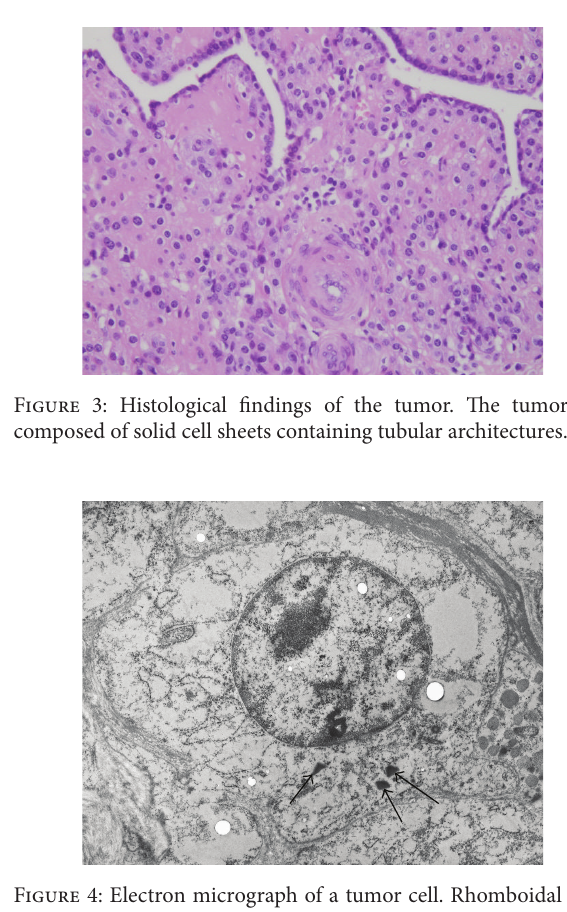
Figure 2: Gross findings of the resected kidney. The tumor located in the middle portion and was well demarcated from the surround- ing structures. The cut surface was white to tan in color.